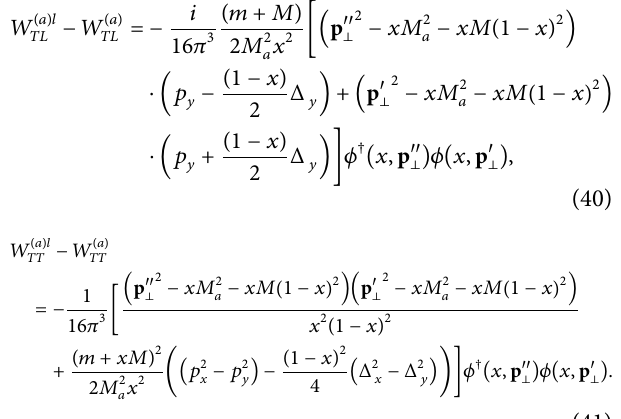
Figure 1: The plot of Wigner distribution 휌 (left panel) and 𝑑 -quark (right